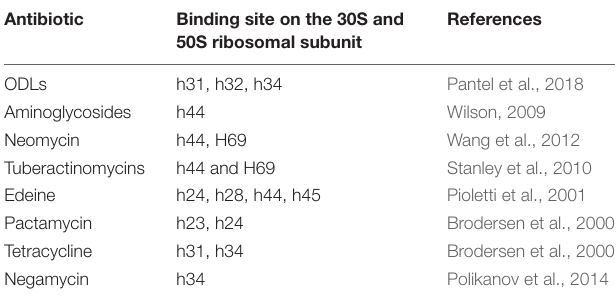
Antibiotic Binding site on the 30S and 50S ribosomal